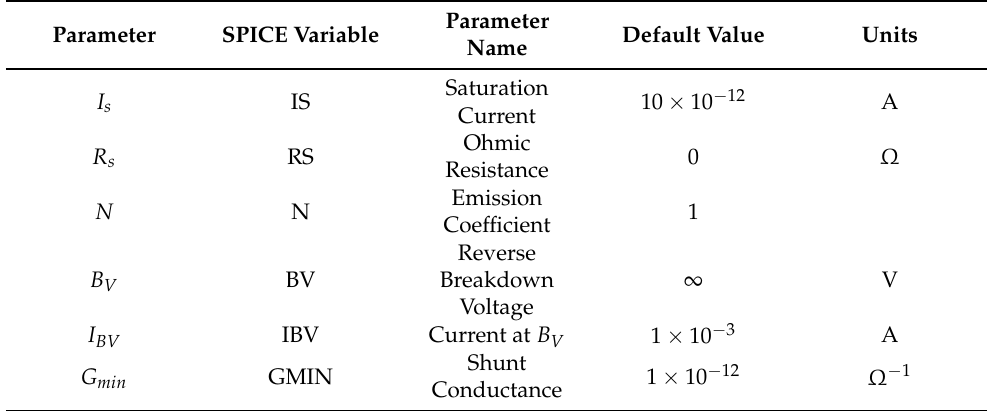
Table 3. Default parameters of the SPICE LSDM. From [18,26].